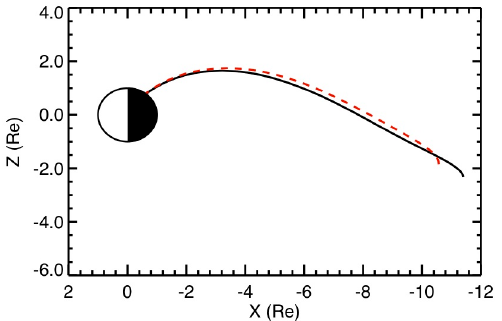
Fig. 6a. (a) shows the Alfv´en travel path along the TH-D field lines from the footprint in the ionosphere, passing through the onset arc at 03:58:12UT shown in the snapshot in Fig. 4b, to the dipolarization region based on the AM02 field model of Kubyshkina et al. (2009). The dashed red curve is for the E-1 event, the solid black curve is for the E-2 event.